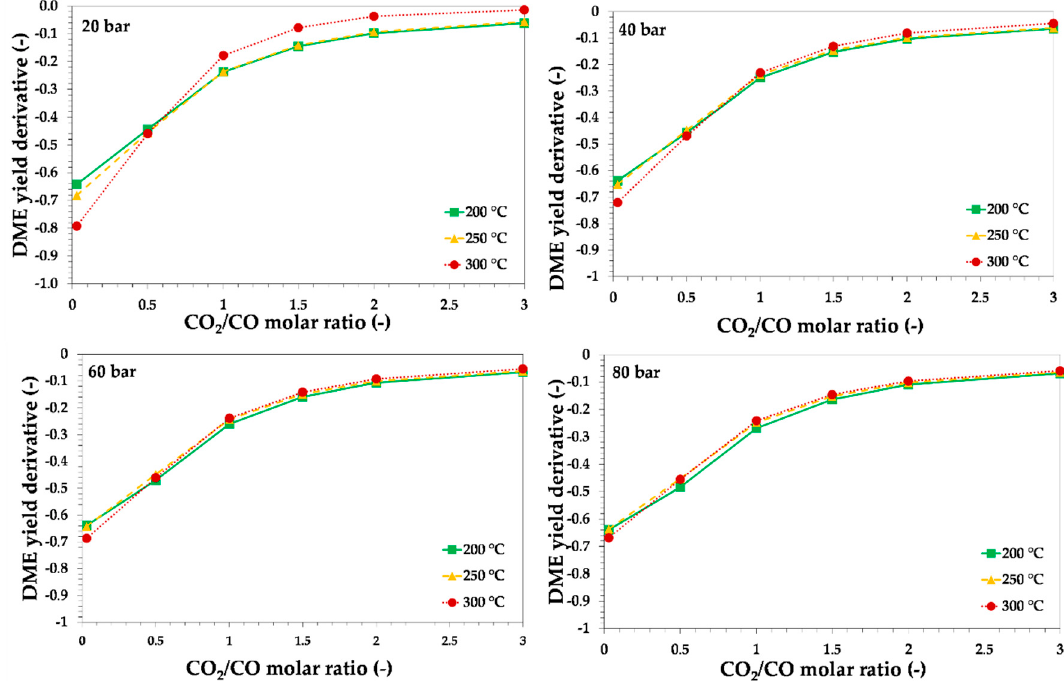
Figure 8. Theoretical equilibrium DME yield derivative with respect to CO 2 /CO molar ratio as a function of the initial CO 2 /CO molar ratio, reaction temperature and pressure, for syngas with H 2 /CO = 2. Lines are only a guide for the reader.